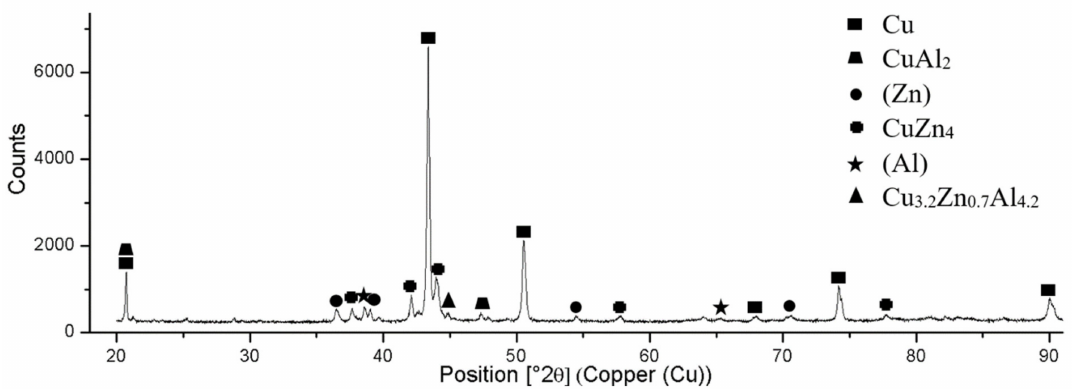
Figure 22. The XRD analysis of fractured surface in Al7075/Zn5Al3Cu/Cu